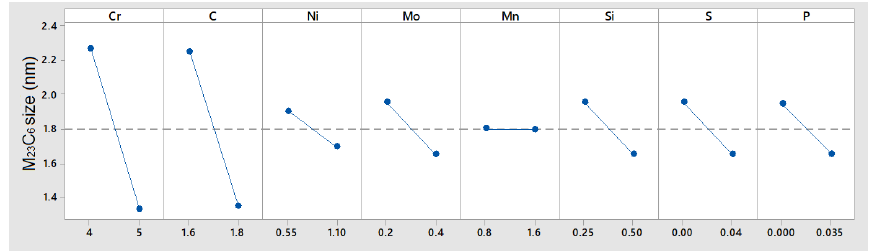
Figure 12. M 23 C 6 precipitates’ size in nanometers for the DOE Thermocalc simulation. Main average effects.